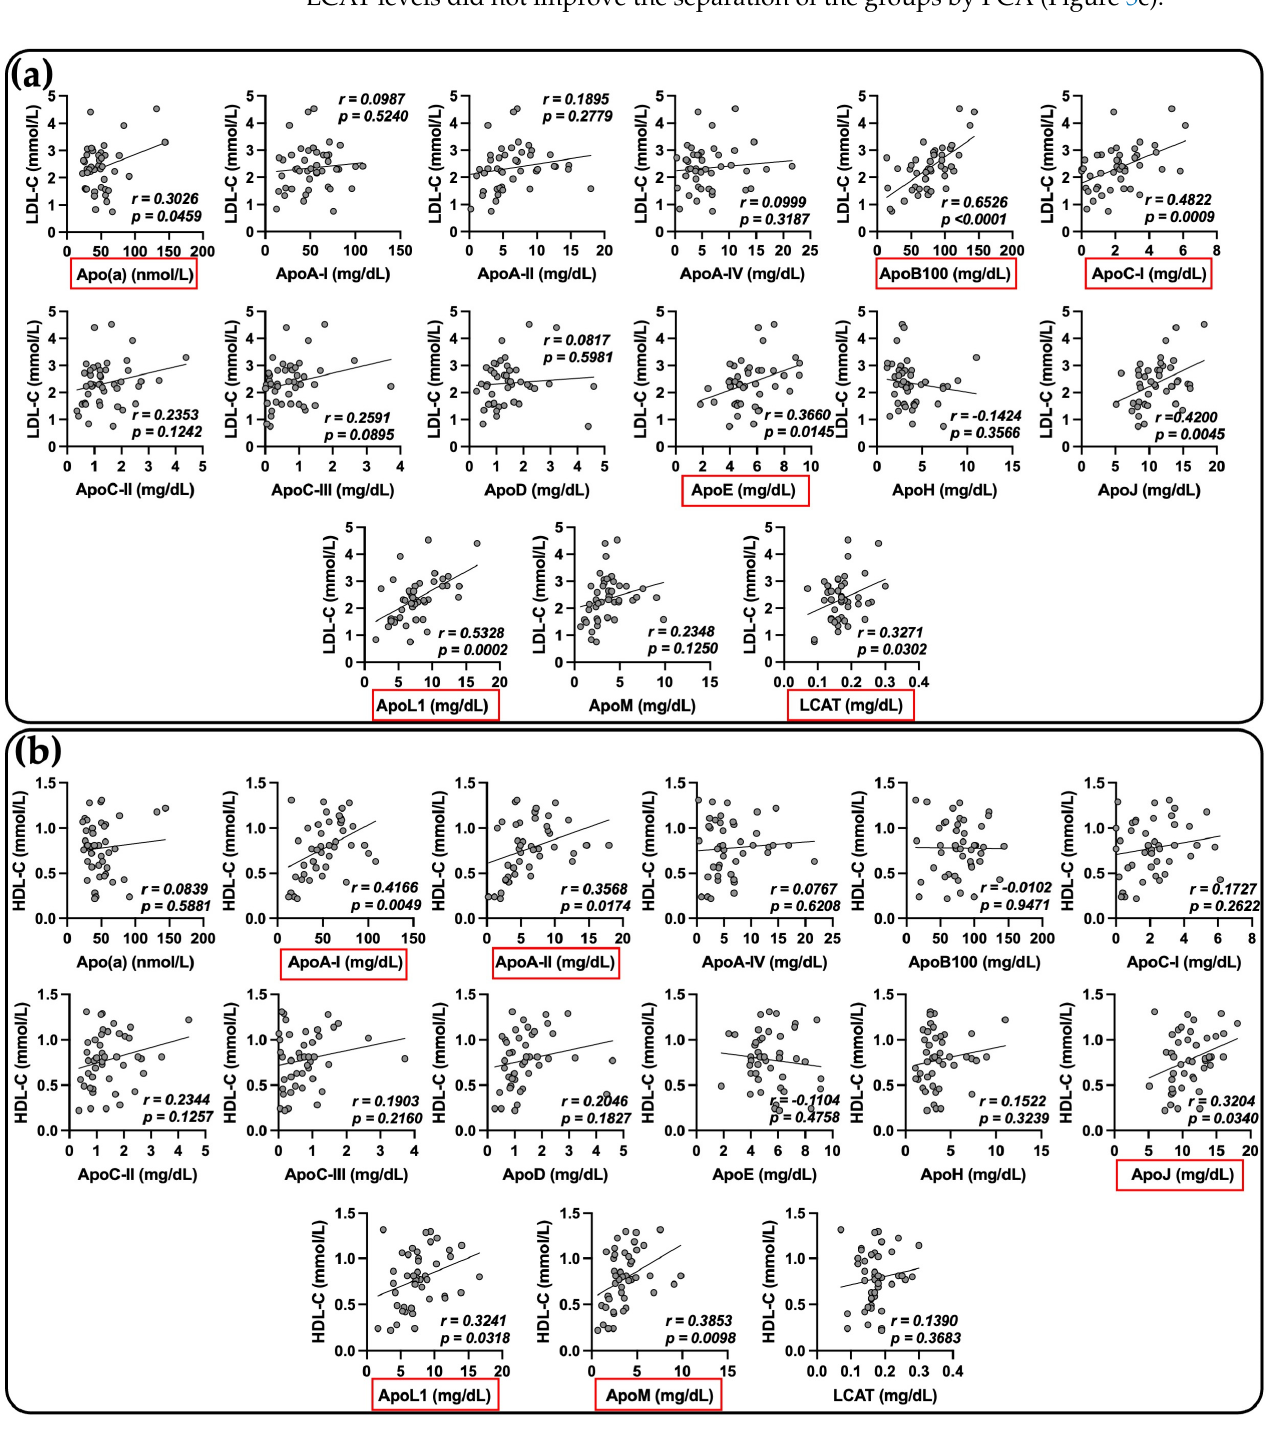
Figure 4. Pearson correlations between apolipoprotein concentrations and LDL-C levels ( a ) and HDL- C levels ( b ). Quantification of 14 apolipoproteins and LCAT was performed by mass spectrometry directly from the plasma of severe COVID-19 patients. LDL-C and HDL-C levels were measured by routine enzymatic methods. Statistically significant positive correlations are shown in red.